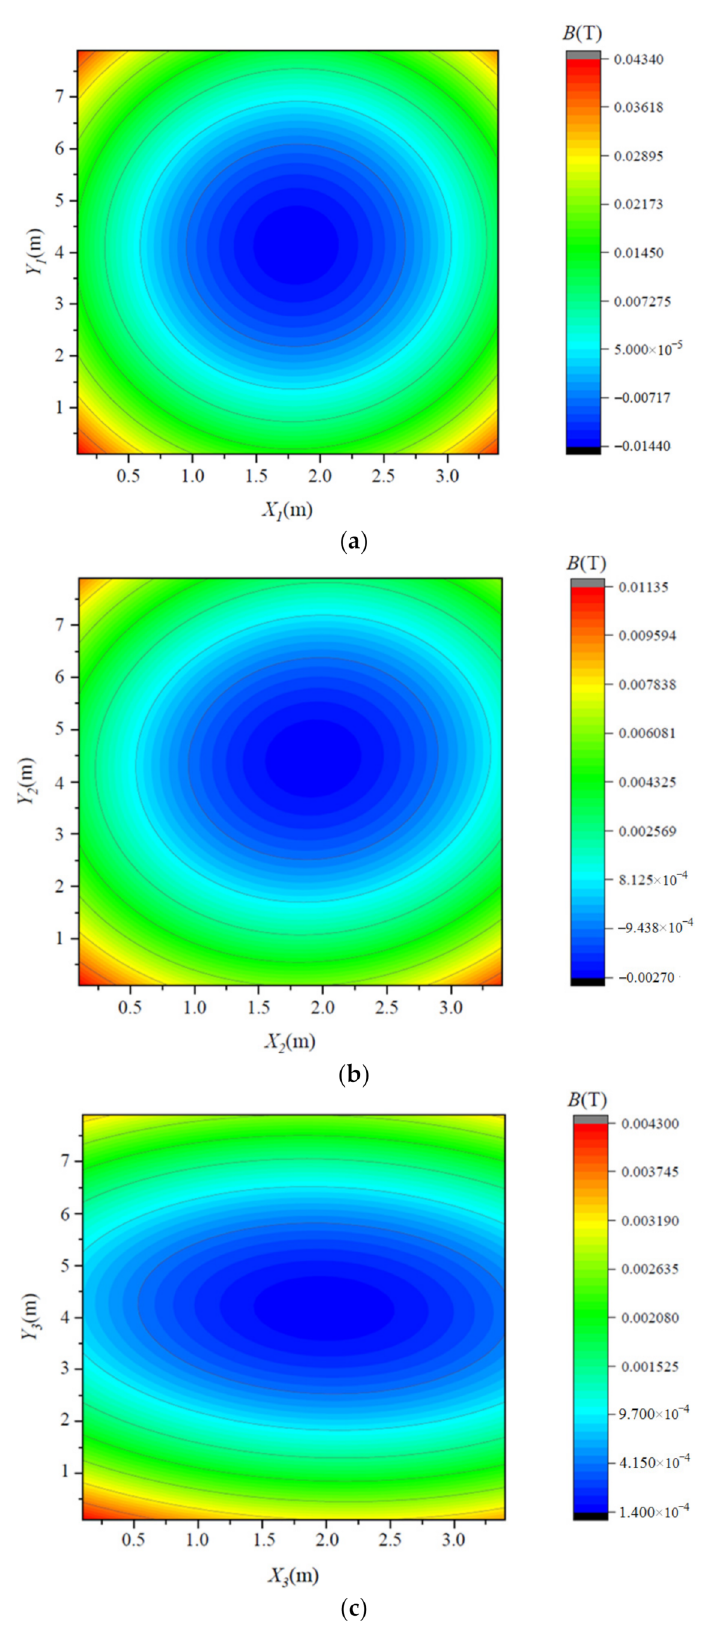
Figure 11. Magnetic field distributions under +10/350 µ s and 100 kA. ( a ) Mesh 1, ( b ) mesh 2, ( c ) mesh